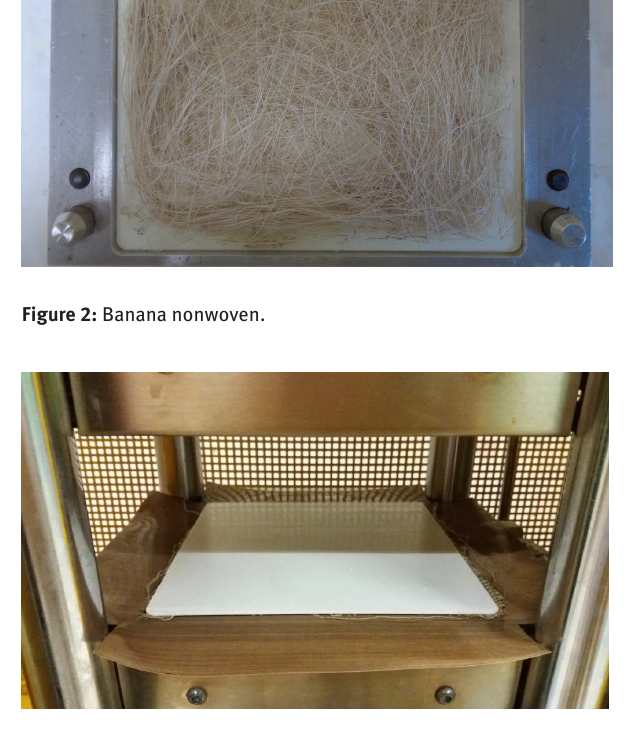
Figure 3: PP and linen fabric placed in the hot plate press for